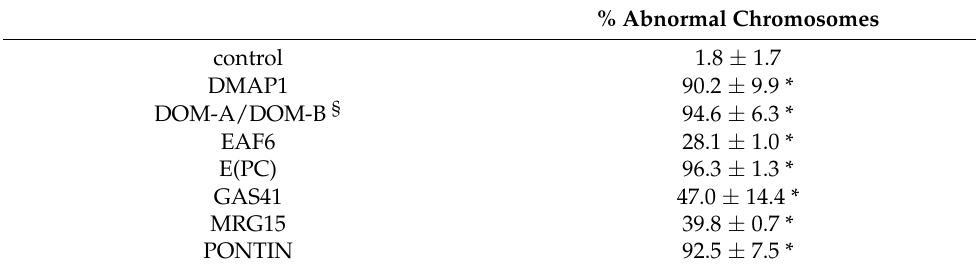
Table 3. Quantification of polytene chromosome defects after silencing of genes coding for the sub- units under investigation. About 100 chromosome figures were scored for each subunit. The results are expressed as % mean ± SD values from three independent replicate experiments. * = p < 0.05, compared to the control. § Simultaneous